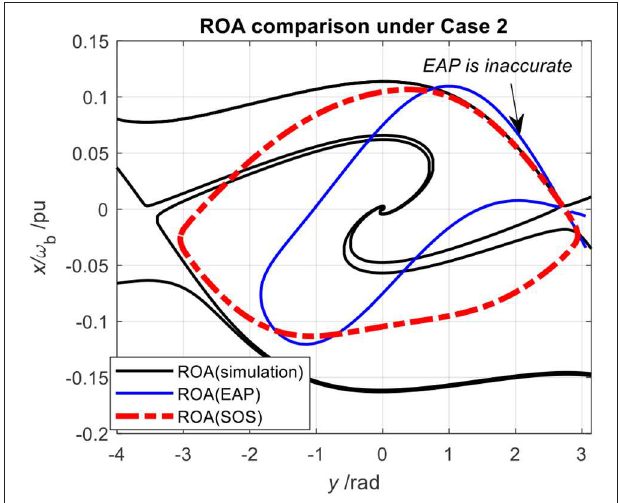
FIGURE 6 | ROA comparisons under a strong grid ( α pll = 10, I ref cd = 1, k scr = 5).